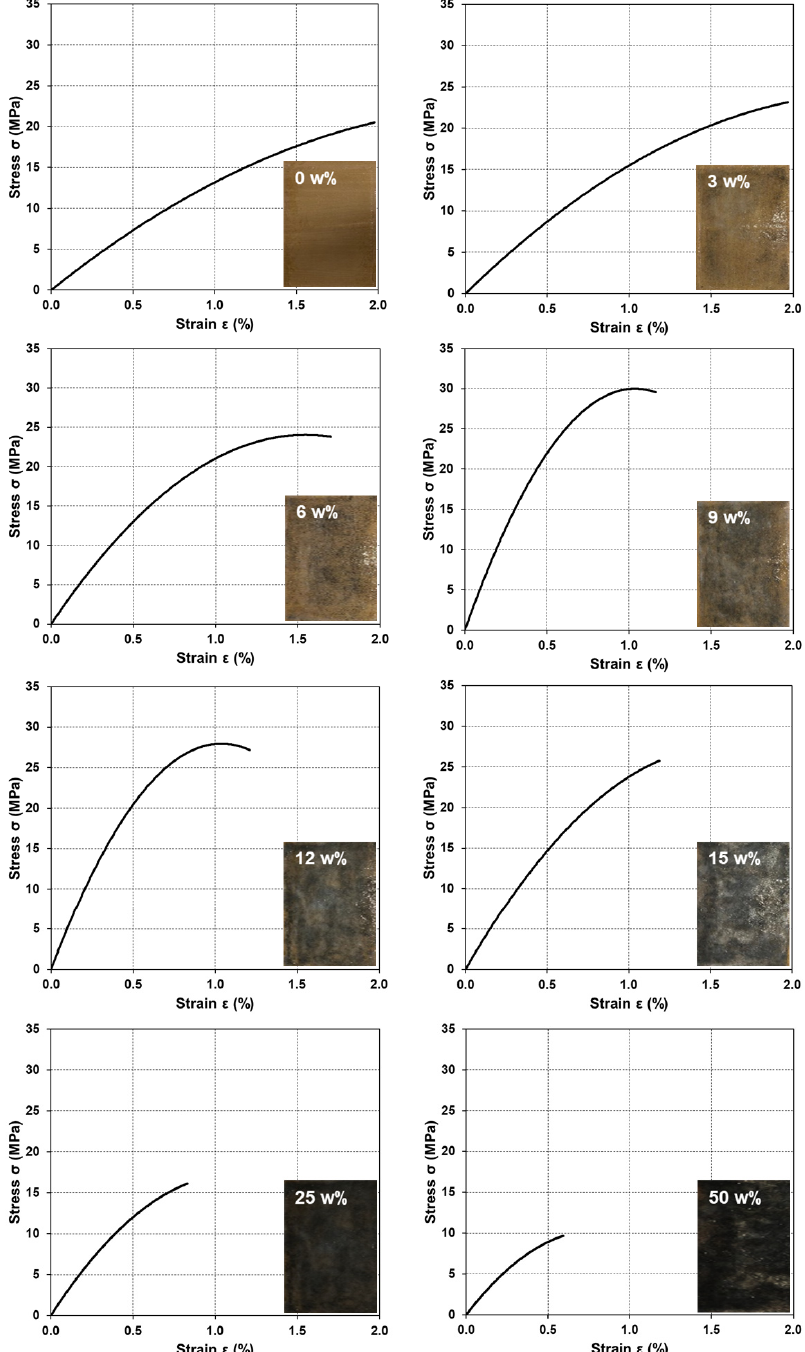
Figure 4. The stress–strain curves obtained from the tensile testing of the GFRE composites upon the addition of different WIF amounts.